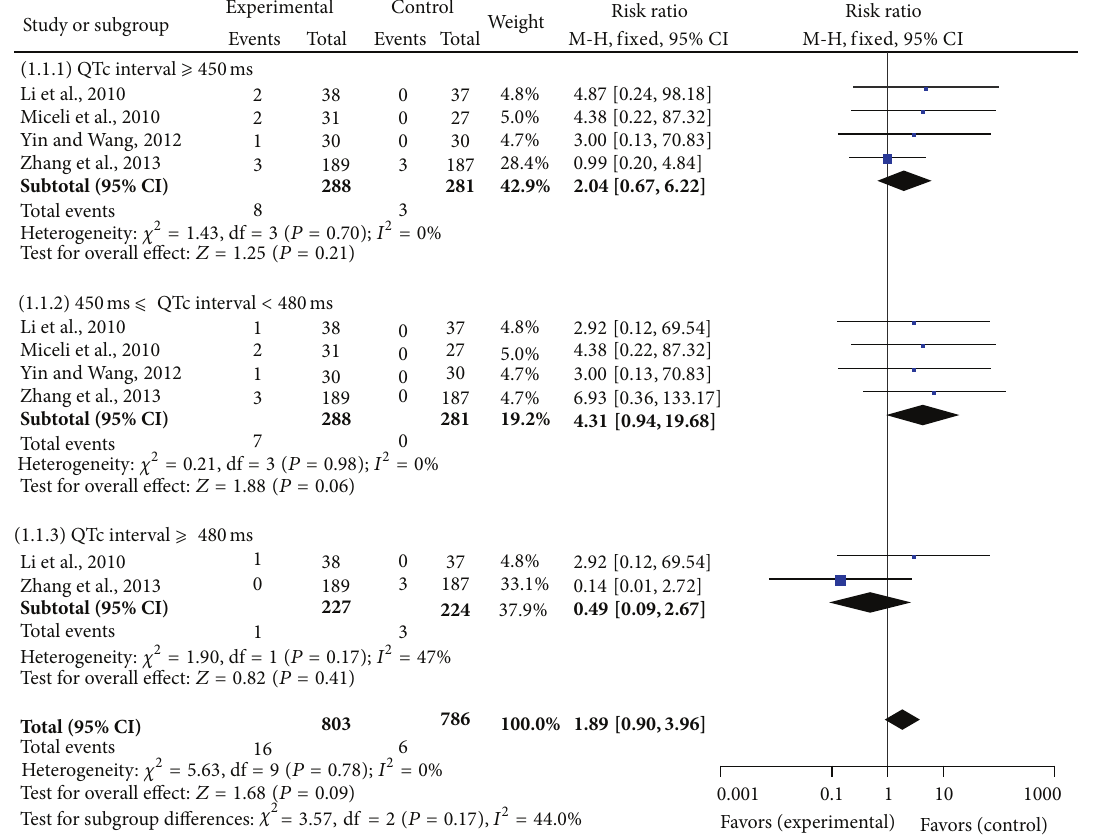
Figure 2: Meta-analysis comparing QTc in patients with intramuscular ziprasidone versus haloperidol.